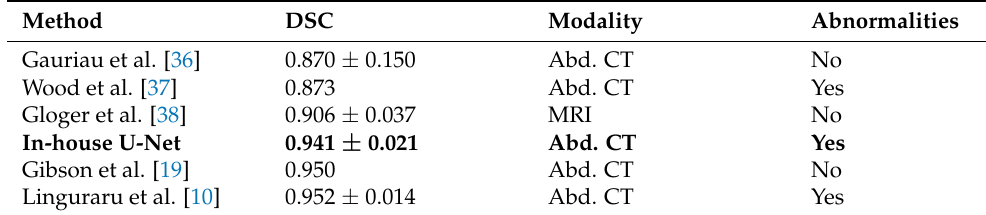
Table 3. Comparison between our in-house U-Net ( in Bold ) and previous